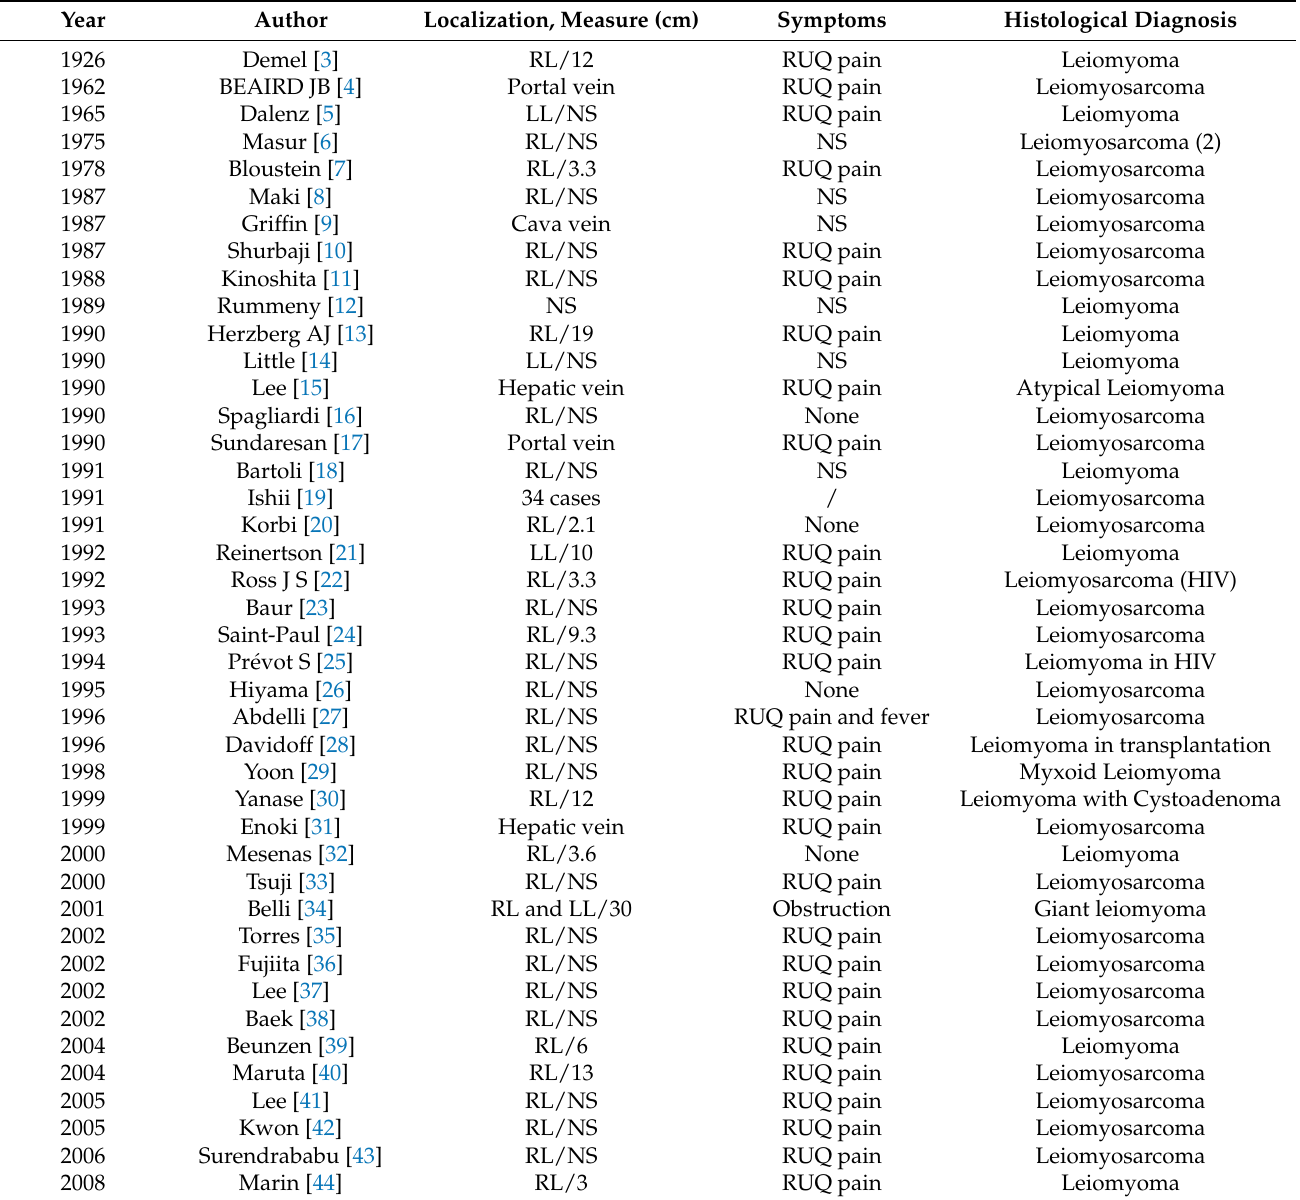
Table 1. Summary of the reported cases of primary leiomyoma and leiomyosarcoma of the liver in